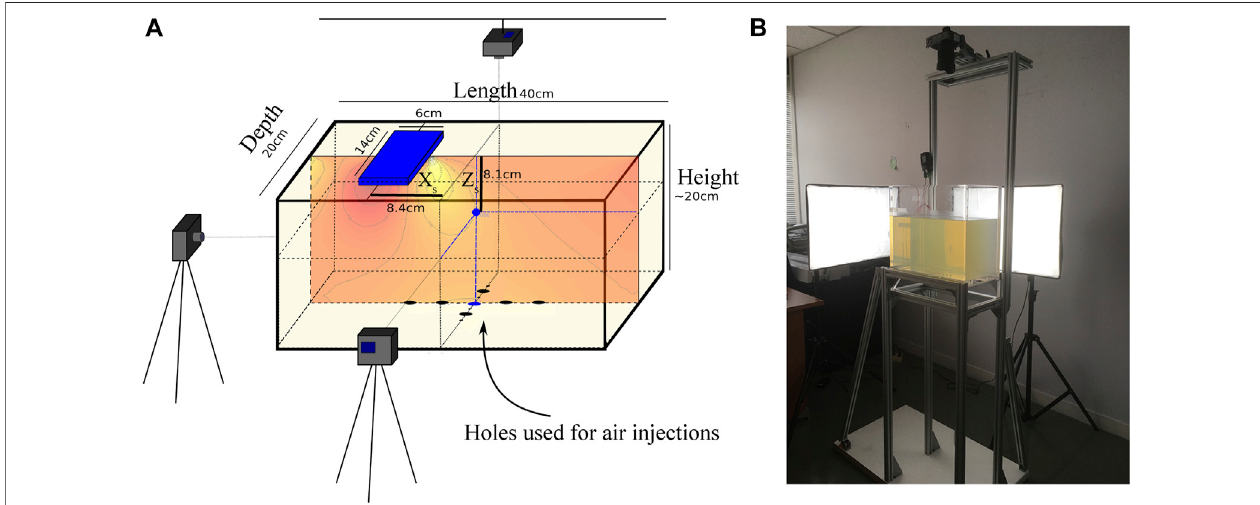
FIGURE 1 | Experimental setup used to performed the air injections. (A) Sketch of the gelatin container. Air is injected through holes in the bottom of the tank, the blue dot is for the position of the air- fi lled crack tip when the load is applied at the surface and is characterized by its horizontal ( X s ) and vertical ( Z s ) distances from the centeroftheload.Across-sectionalongtheplaney=0showstheshearstressinducedbytherigidloadandnumericallyestimatedwithCOMSOL. (B) Photographofthe experimental setup.